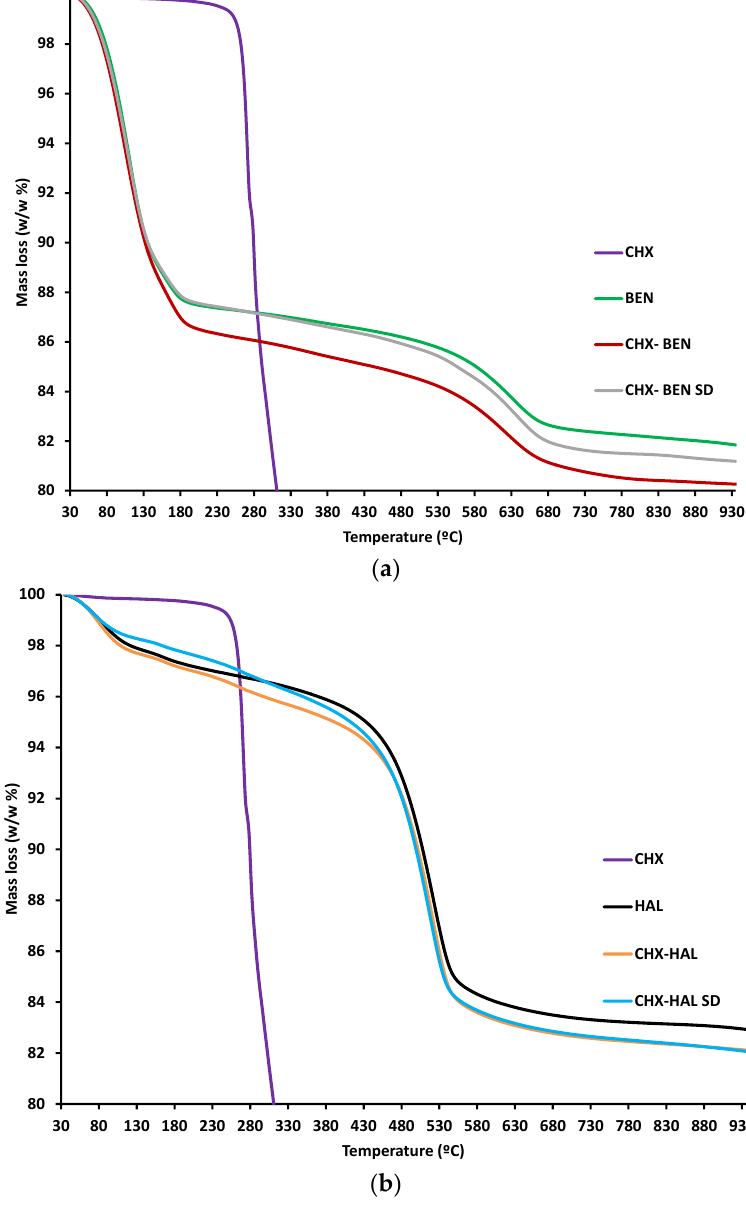
Figure 4. TGA curves of nanohybrids and pristine components: ( a ) BEN-based nanohybrids; ( b ) HAL-based nanohybrids. CHX: chlorhexidine dihydrochloride; BEN: bentonite; HAL: halloysite; CHX – BEN and CHX – HAL: nanohybrids obtained by intercalation solution technique; CHX – BEN SD and CHX – HAL SD: nanohybrids obtained by spray-drying technique.